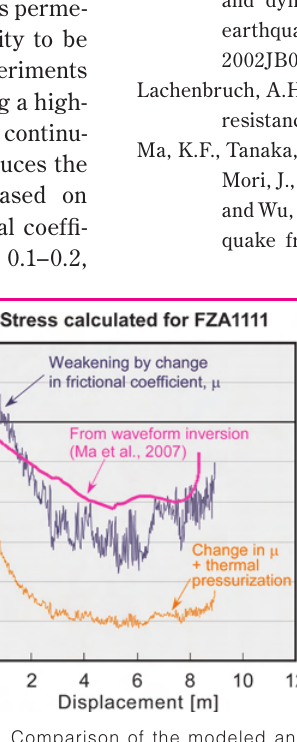
Figure 1. Comparison of the modeled and observed fault shear traction